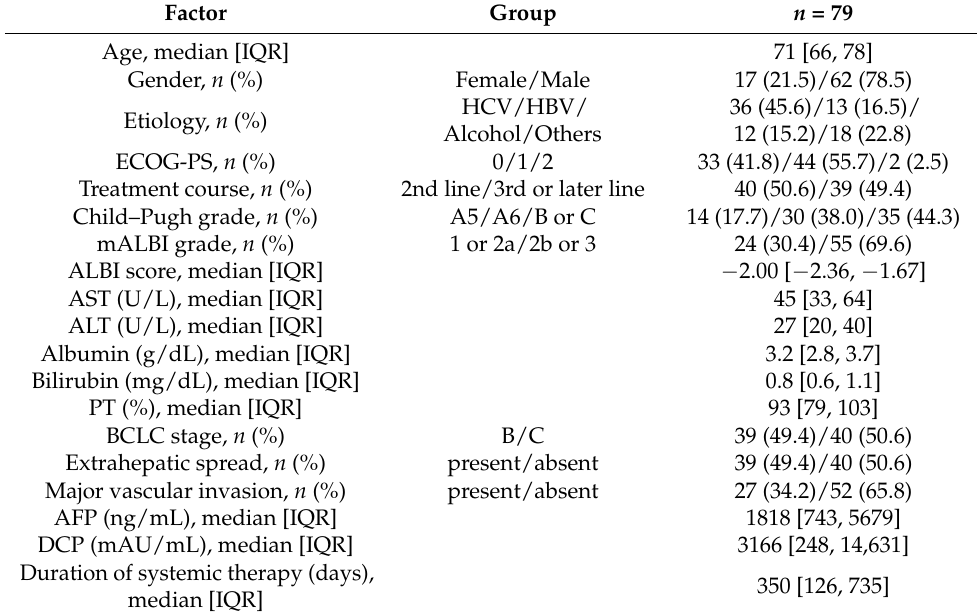
Table 1. Baseline characteristics.